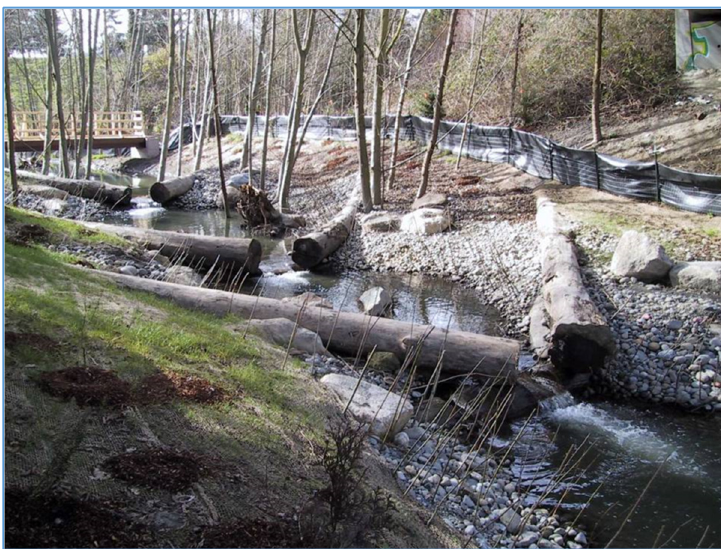
Figure 1. Example of a habitat-reconstruction project to address the perceived absence of large woody material and pools as key limiting factors in an urban stream (Longfellow Creek, Seattle, WA, USA). Other factors, however (largely water chemistry and flow), have precluded any meaningful biological success here [6] (photo by D. Booth).